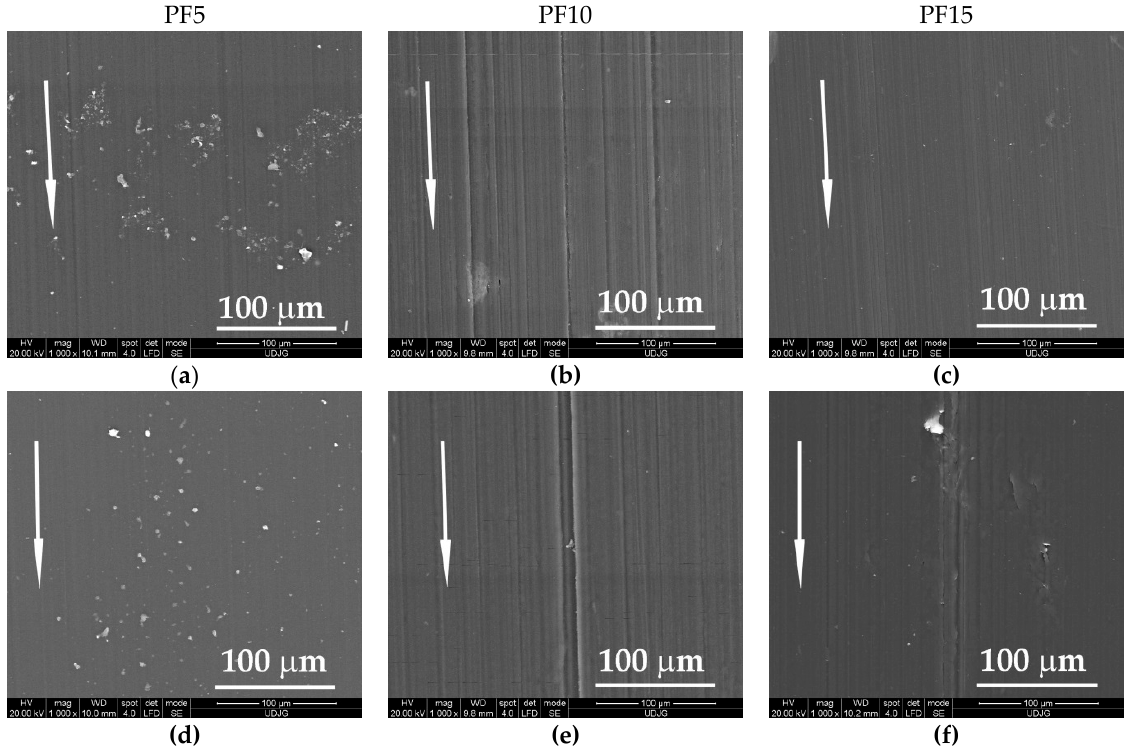
Figure 6. Details of the worn surface for the block made of PF5, PF10 and PF15, L = 5000 m and v = 0.25 m/s: ( a ) PF5, F = 1 N; ( b ) PF10, F = 1 N ; ( c ) PF15, F = 1 N; ( d ) PF5, F = 5 N; ( e ) PF10, F = 5 N and ( f ) PF15, F = 5 N.